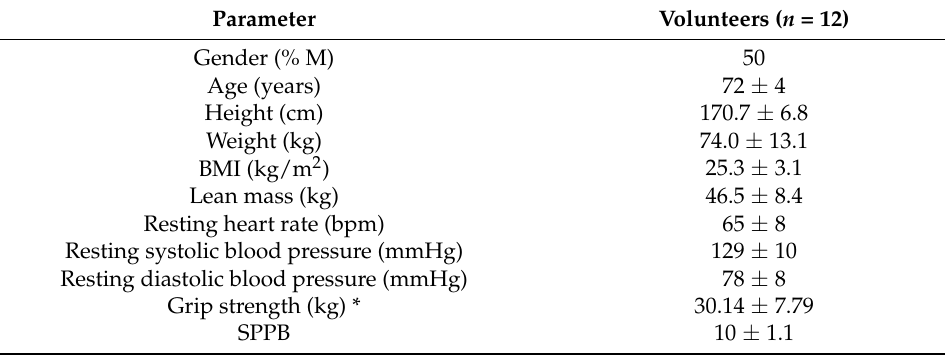
Table 1. Volunteer characteristics (mean ±